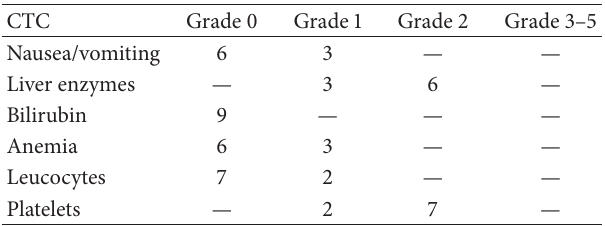
Figure 2: Mena values for the dimensions in 𝑥 , 𝑦 , and 𝑧 axis of the primary site and VAS score before and after RT. 𝑃 < 0.001 , Wilcoxon test. Vertical lines stand for ± SD. Table 2: Acute toxicity ( 𝑛 = 9